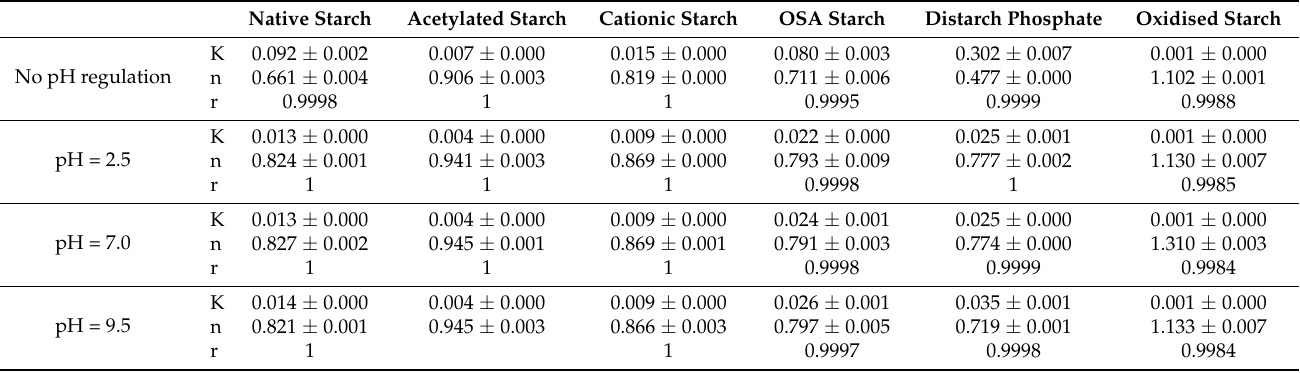
Table 1. Parameters of Ostwald-de Waele rheological equation for the analysed starch samples. Native